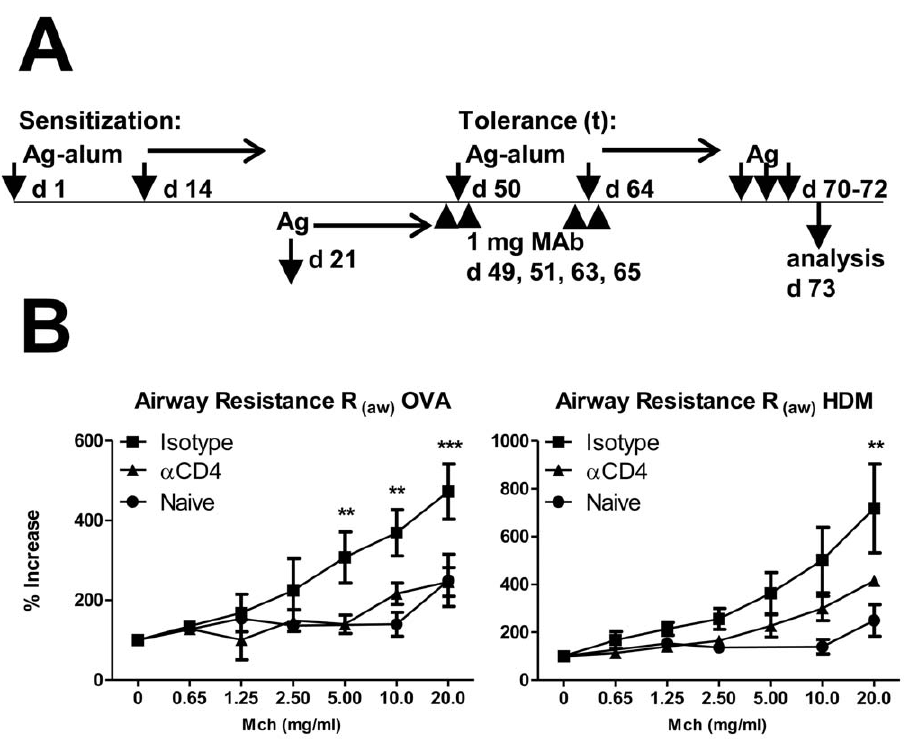
Figure 5. Protection from AHR in animals previously exposed to airways inflammation. (A) Balb/c mice sensitized and challenged i.n. with HDM-alum or OVA-alum were tolerized to the same antigens on days 50 and 64, and challenged i.n. with the same antigens. (B) The animals treated with HDM or OVA under the cover of anti-CD4 were protected from AHR in response to inhaled MCh (n=6, ** P , 0.01 or *** P , 0.001 as indicated). Data are representative of two independent experiments.